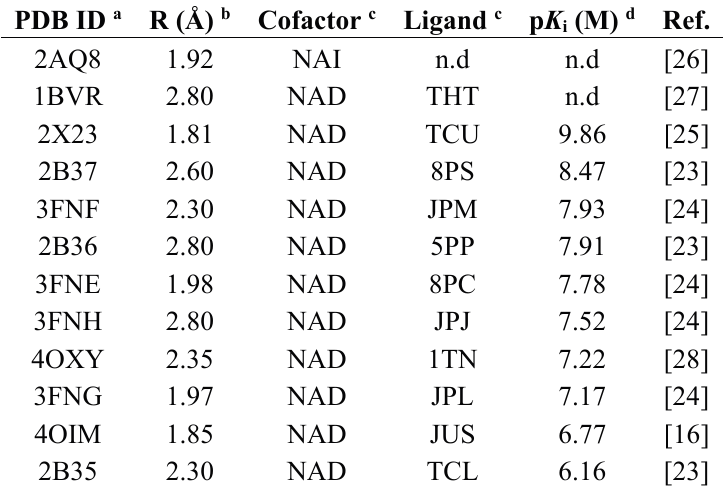
Table 1. Description of the InhA-cofactor-ligand complexes used as starting structures in the molecular dynamics